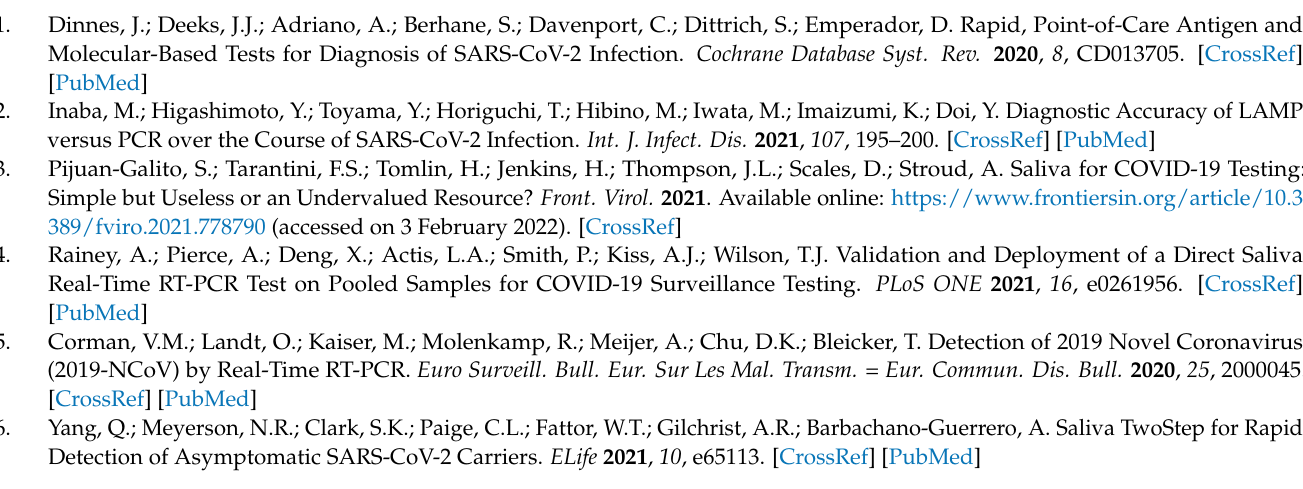
Figure 6. Comparison between genuine RNase P amplification (green curve), RNase P contamination (red curve), and signal drift (black curve) in the RNase P channel. The drift can be automatically corrected by the analysis software, but this could result in curves such as the red one also being flattened. The purple horizontal line represents the RFU threshold for RNase P.